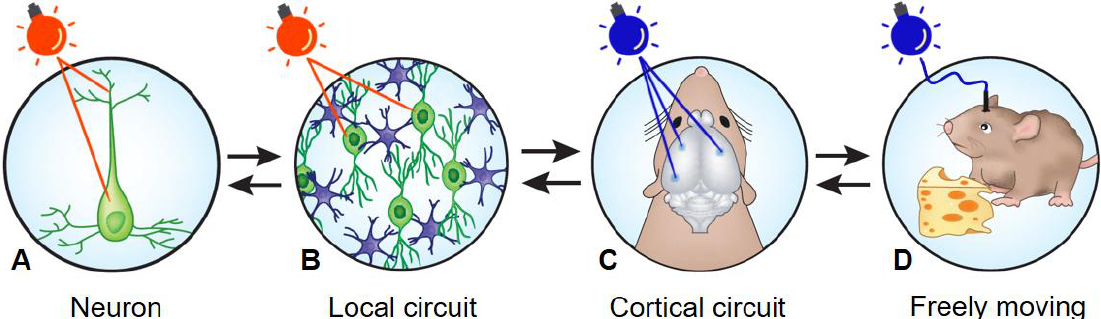
Figure 1. Optogenetic manipulation with di ff erent spatial resolutions. ( A ) Representative image of two-photon (2P) excitation method, which provides temporally precise control of neuronal firing. The high spatial resolution of the technique allows for the stimulating of targeted compartments of individual neurons at the dendritic, somatic, and axonal level. The two-photon beam can be split to irradiate multiple spots in the imaging plane using di ff erent approaches, such as spatial light modulators (SLMs) or holographic projection (HP). ( B ) Spatially patterned excitation sequences can be reproduced to map and modulate the connectivity of individual neurons within local circuits. ( C ) A representative example of one-photon patterned illumination. This technique enables us to trigger extensive cortical network dynamics and mimic natural activity patterns for the investigation of inter- and intra-cortical interactions. ( D ) Deep brain stimulation using optical fibres provides a method to probe the causal relationships between the activity of neuronal ensembles and behaviour in the most natural conditions allowed. Adapted by permission from Springer Nature [17].